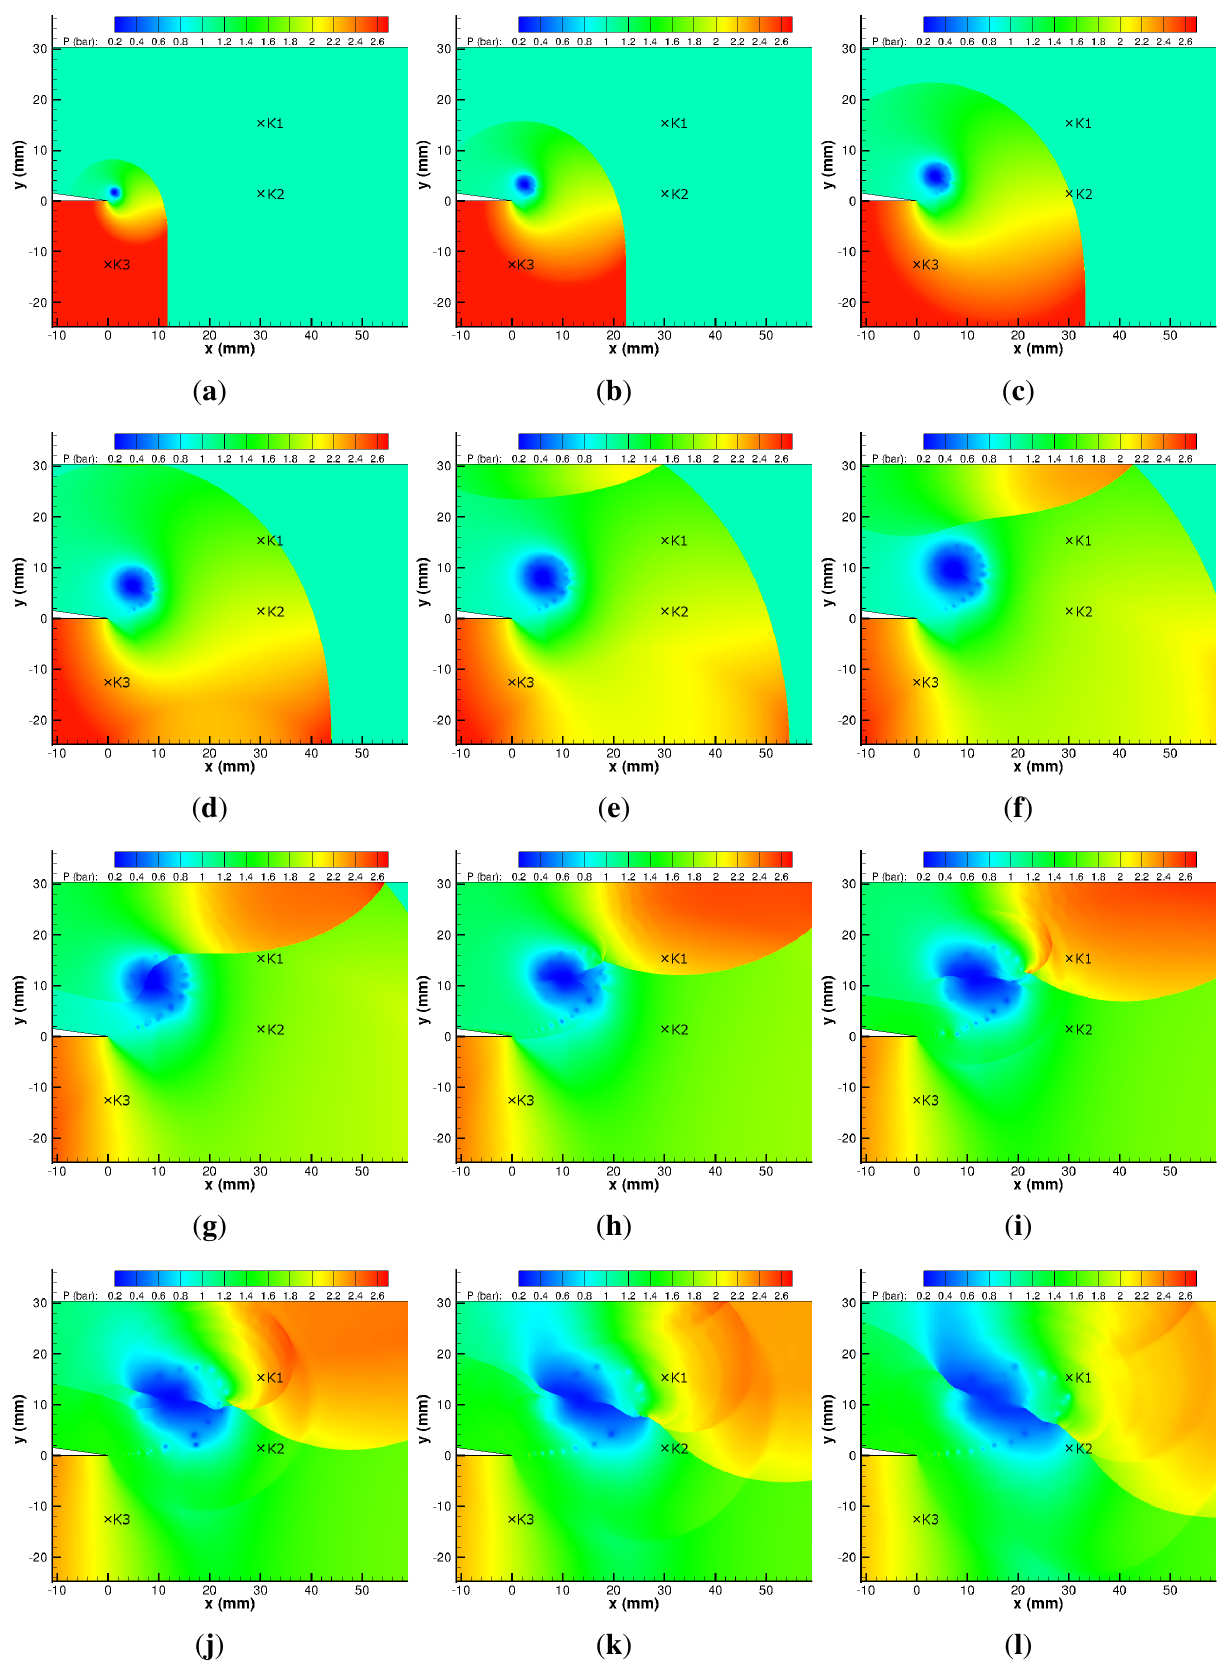
Figure 15. CFD pressure map of M = 1 . 55 shock diffraction process. ( a ) 20 µ s; ( b ) 40 µ s; i ( c ) 60 µ s; ( d ) 80 µ s; ( e ) 100 µ s; ( f ) 120 µ s; ( g ) 140 µ s; ( h ) 160 µ s; ( i ) 180 µ s; ( j ) 200 µ s; ( k ) 220 µ s; ( l ) 240 µ